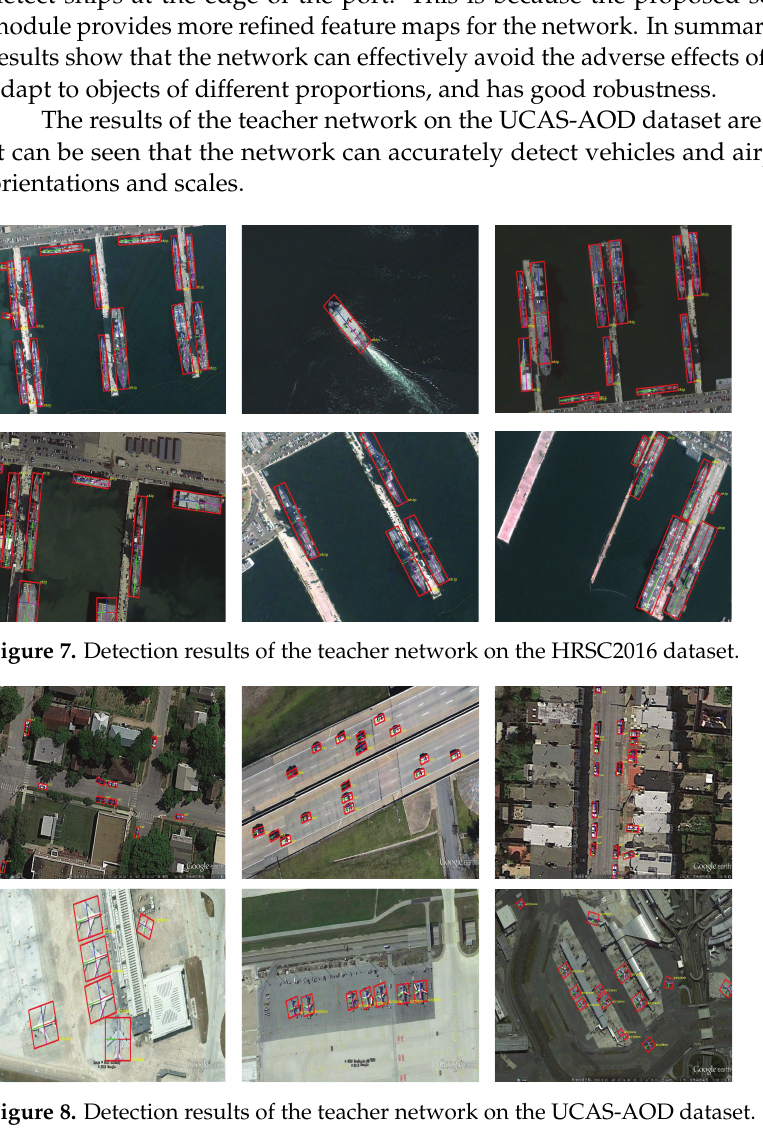
Figure 8. Detection results of the teacher network on the UCAS-AOD